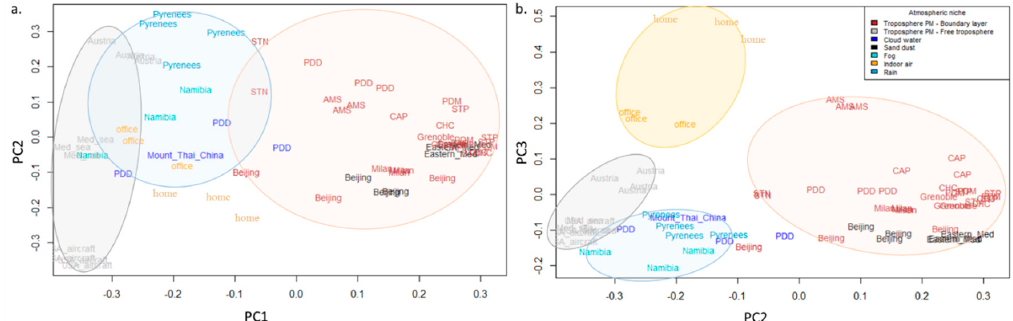
Figure 2. Distribution of the samples coming from different phases of the atmosphere (cloud water, rain, fog, planetary boundary layer, and free troposphere particulate matter) based on the bacterial community structure. Public 16S rRNA gene sequencing based datasets were downloaded on public databases (Table S1 in Supplementary Data). Reads were filtered based on quality using FASTX-Toolkit then PANDAseq [40] was used to assemble the read 1 and read 2 using the RDP algorithm (Ramer–Douglas–Peucker algorithm). The resulting sequences were annotated at the genus level by RDP Classifier [41] using the RDP 16srrna database and an assignment confidence cutoff of 0.6. The PCo (Principal coordinates) analysis (components 1 and 2 in ( a ), components 2 and 3 in ( b )) of the Bray–Curtis dissimilarity matrix is based on the relative abundances of the different bacterial genera.